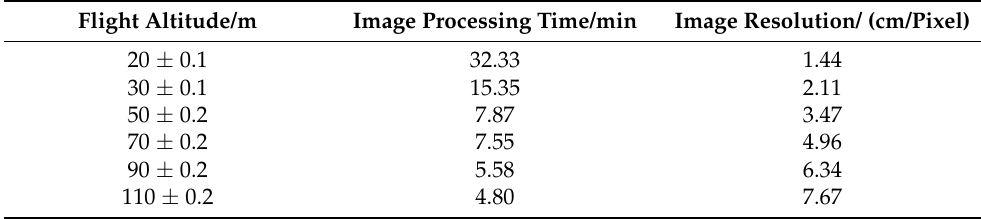
Table 1. Image resolution and processing efficiency at each flight altitude.